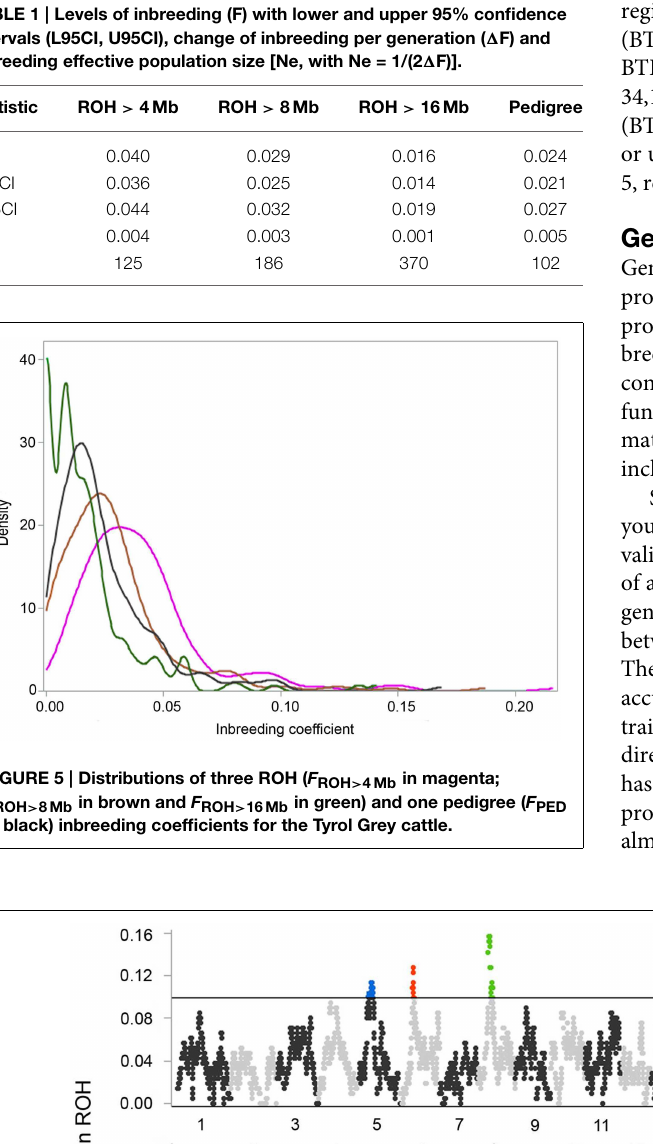
Frontiers in Genetics |